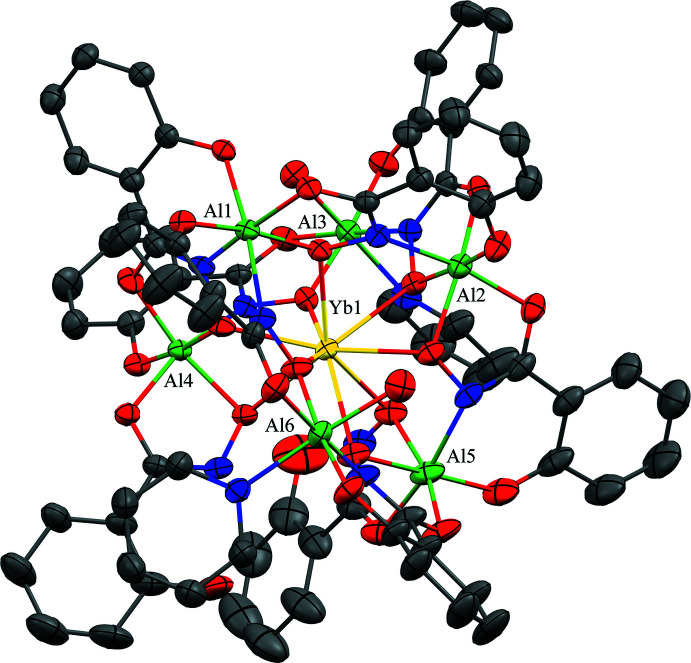
The single-crystal X-ray structure of [Hpy]2[YbAl6(H2shi)2(shi)7(py)1.855(H2O)2]·7.386py·H2O, 3, with displacement ellipsoids at the 50% probability level. See Fig. 1 ▸ for additional display details.